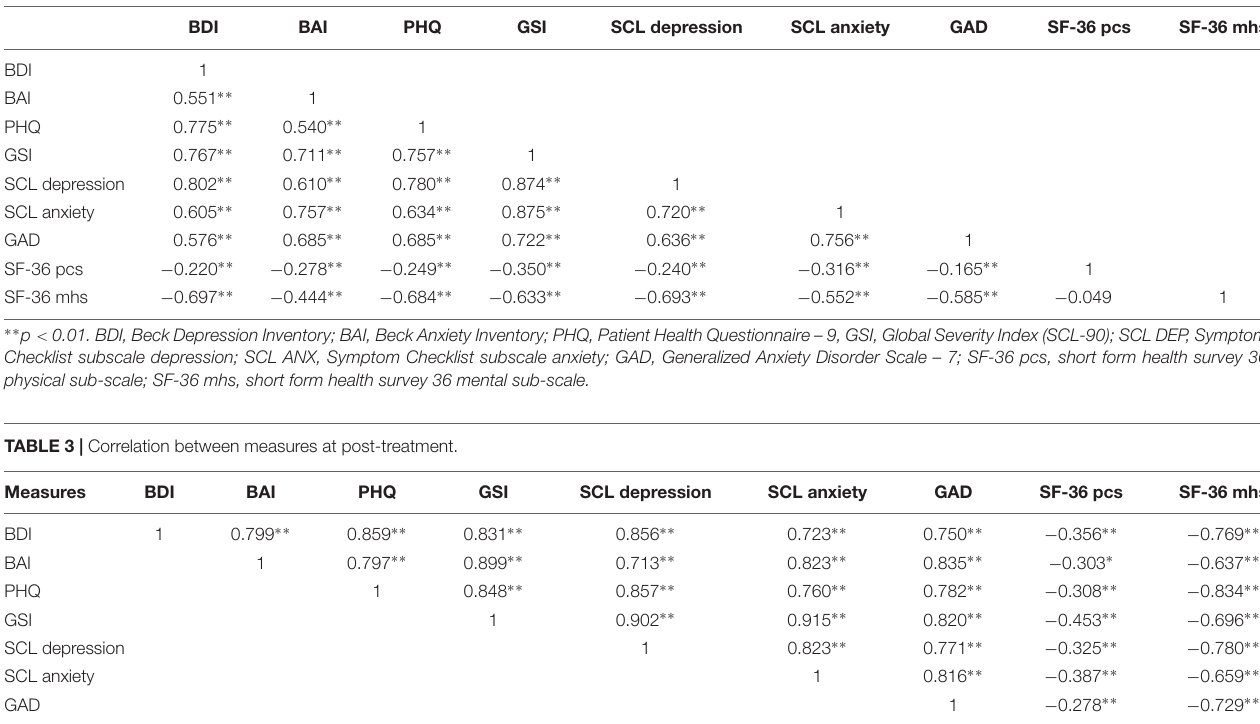
TABLE 2 | Correlation between measures at pre-treatment.